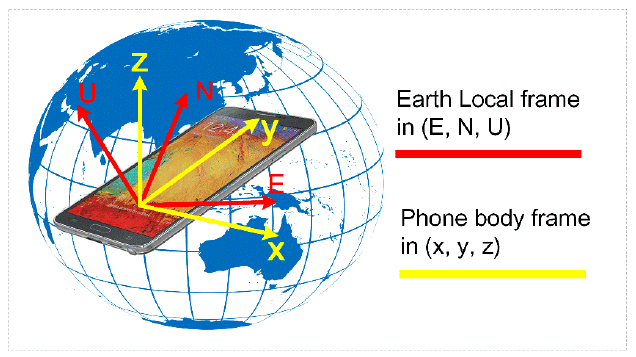
Figure 2. The smartphone sensor body frame and Earth local frame.